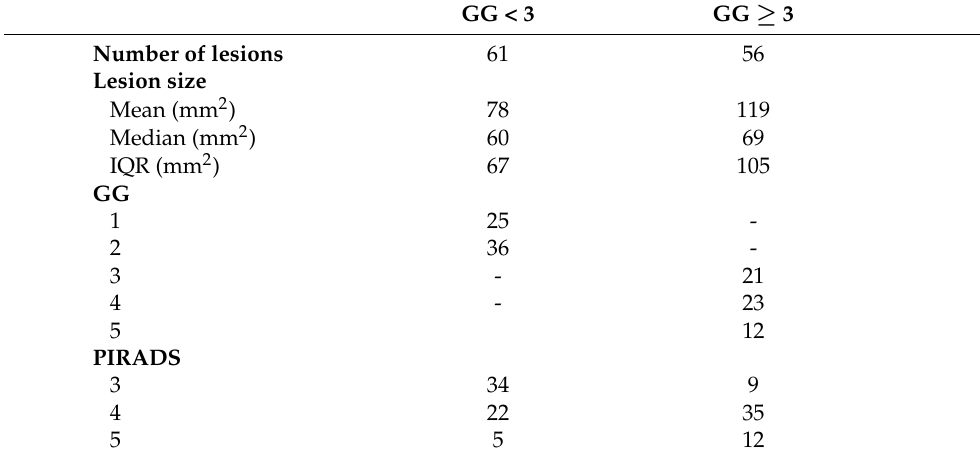
Table 2. Clinical characteristics of PCa